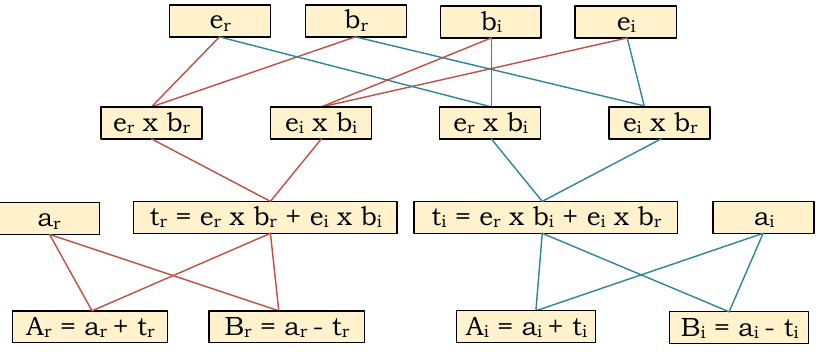
Figure 7. Directed acyclic graph of a butterfly